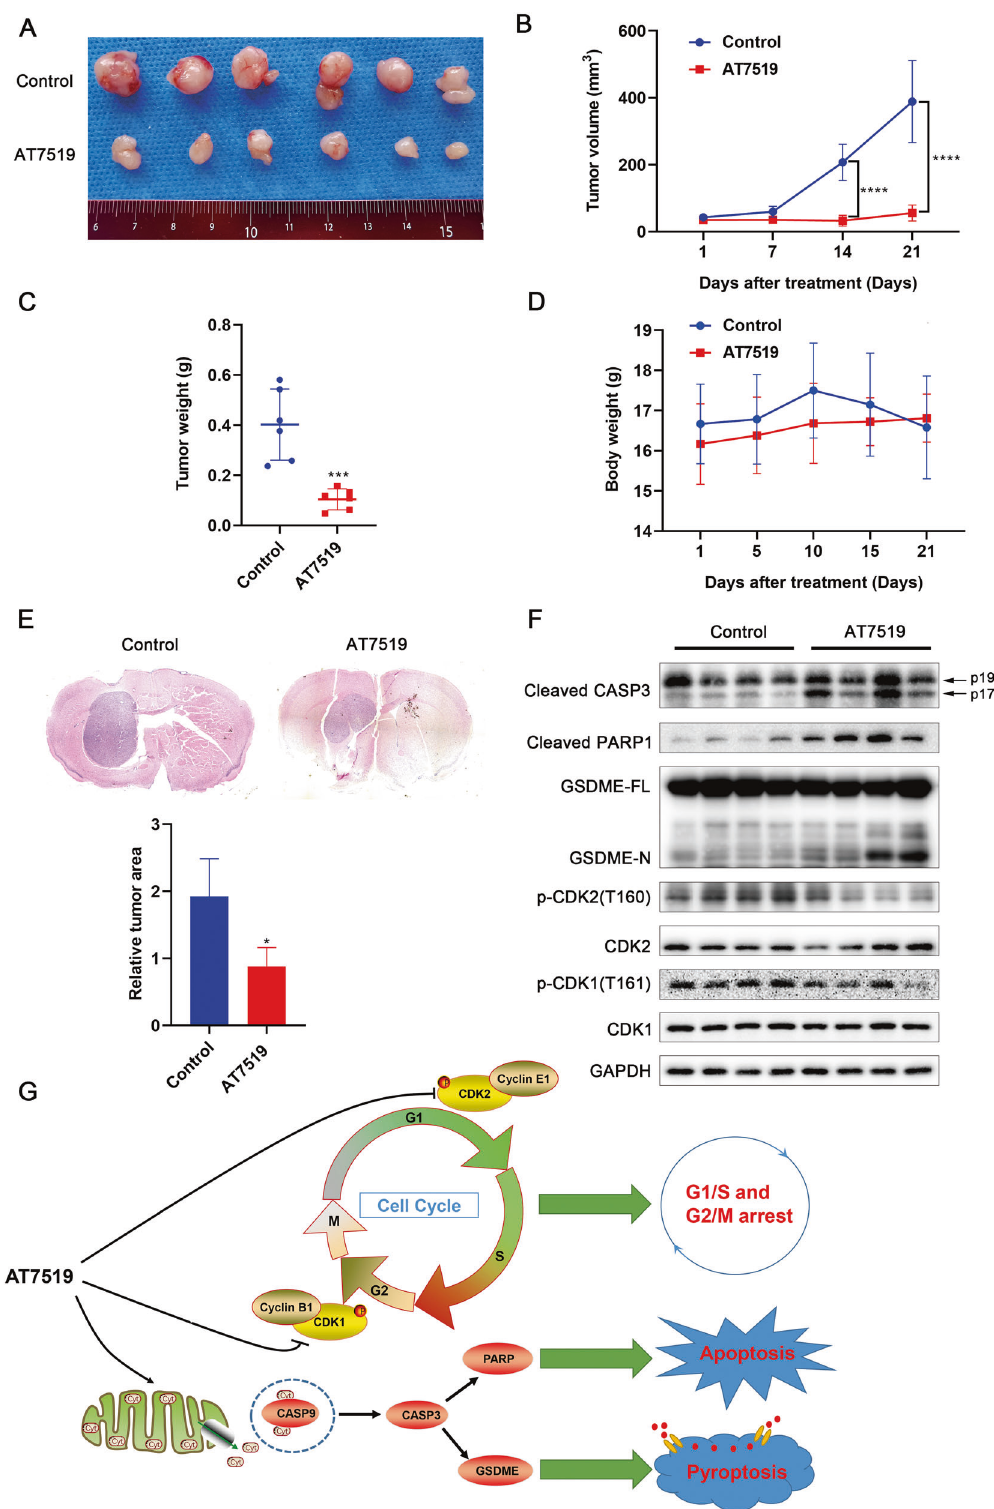
Fig. 6 AT7519 inhibits tumor growth in glioblastoma xenograft mice. A Image of the subcutaneous xenograft tumors formed in nude mouse models. B Tumor volumes were measured and calculated every week. **** P < 0.0001 as assessed by two-way ANOVA followed by Sidak ’ s multiple test. C Tumors were excised and weighed at the end of the experiment. *** P < 0.001 by Student ’ s t -test. D Body weight of nude mice during administration of AT7519. E Representative H&E-stained images of the intracranial xenograft model in the AT7519 treatment group and control group. * p < 0.05 as assessed by Student ’ s t -test. F Western blot assay of the apoptosis, pyroptosis, and cell cycle-related key protein expression levels in tumor tissue. G Schematic model of the antitumor mechanism of AT7519 in glioblastoma cells.